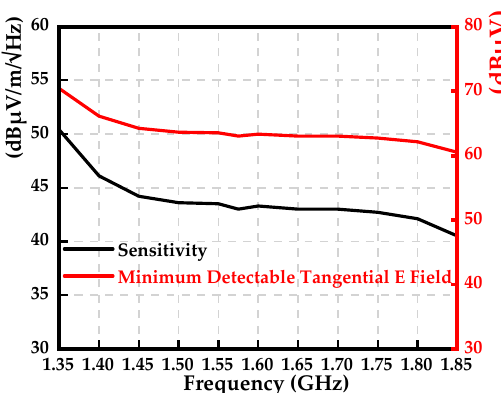
Figure 12. Sensitivity and minimum detectable tangential electric field of the proposed sensor.